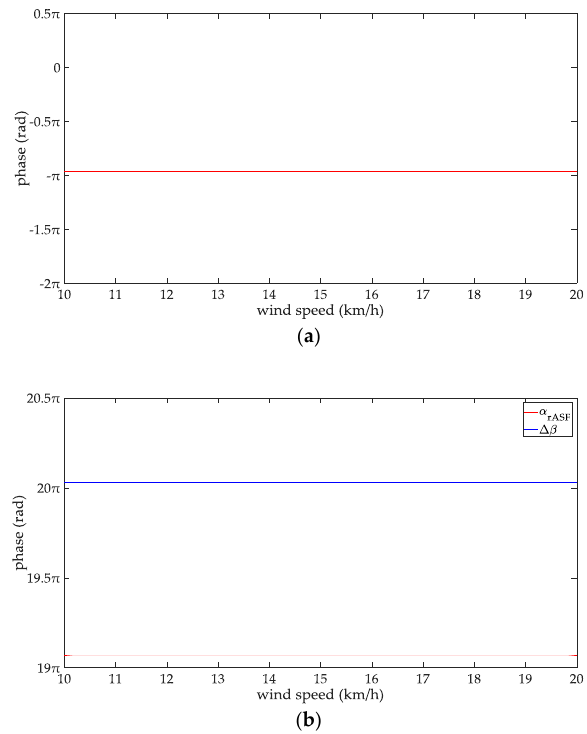
Figure 5. ( a ) The phases of the reflection coefficient changing with the wind speed; and ( b ) the ASFs of the AIS reflected signal changing with the wind speed.